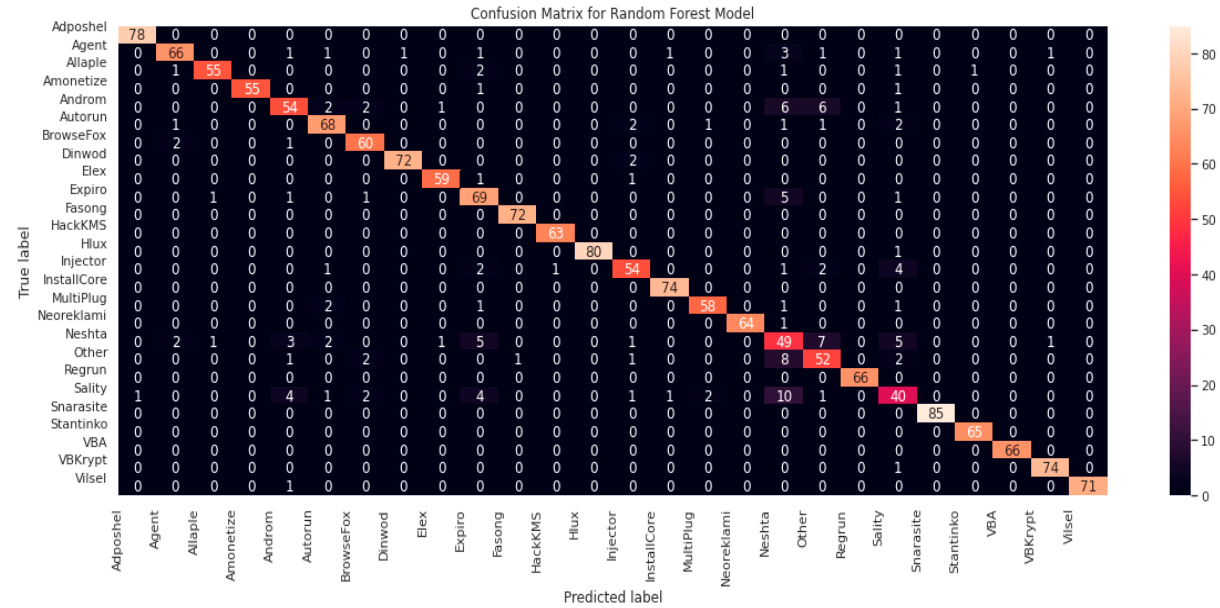
Figure 12. Confusion matrix for the random forest algorithm.